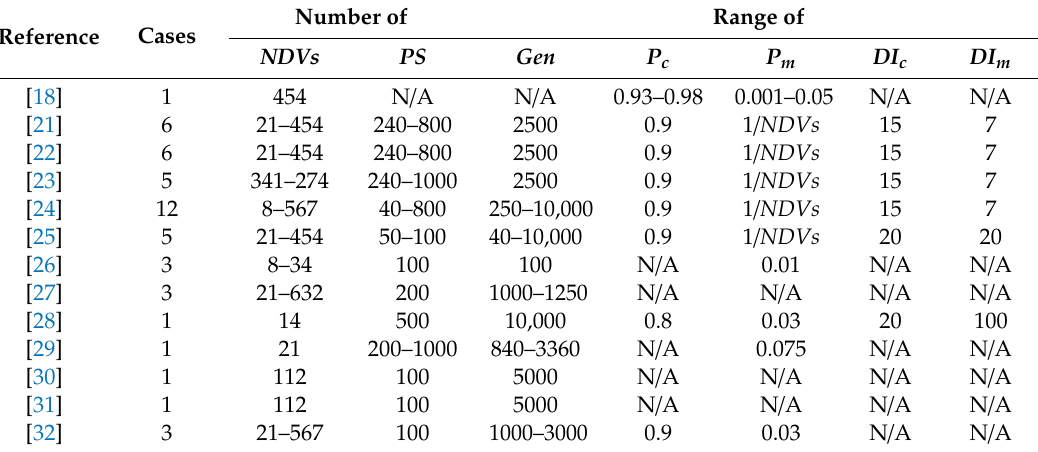
Table 1. Literature survey on the applications of the Non-dominated Sorting Genetic Algorithm II (NSGA-II) to Water Distribution Systems (WDS) design